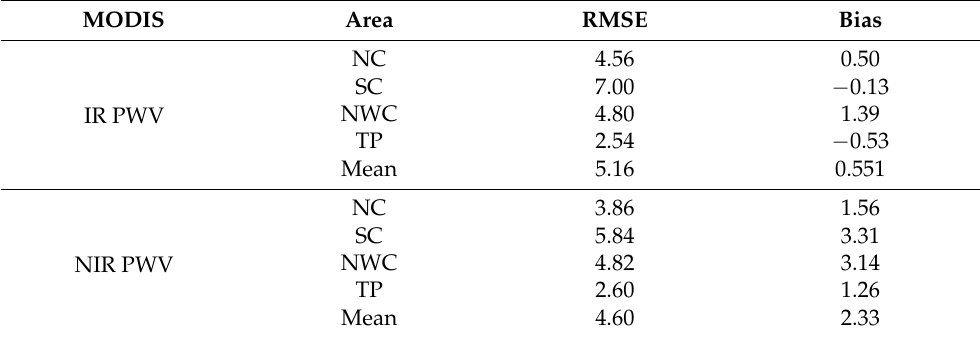
Table 3. Statistical result of PWV differences between MODIS IR/NIR and radiosonde PWV (unit: mm).